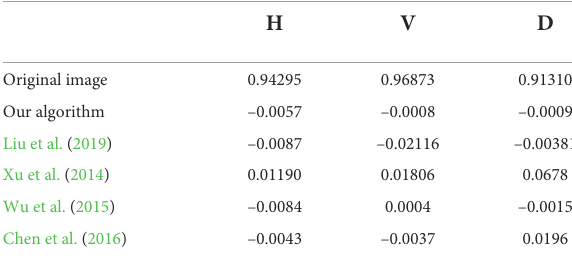
TABLE 2 Comparison of correlation coefficients of encryption